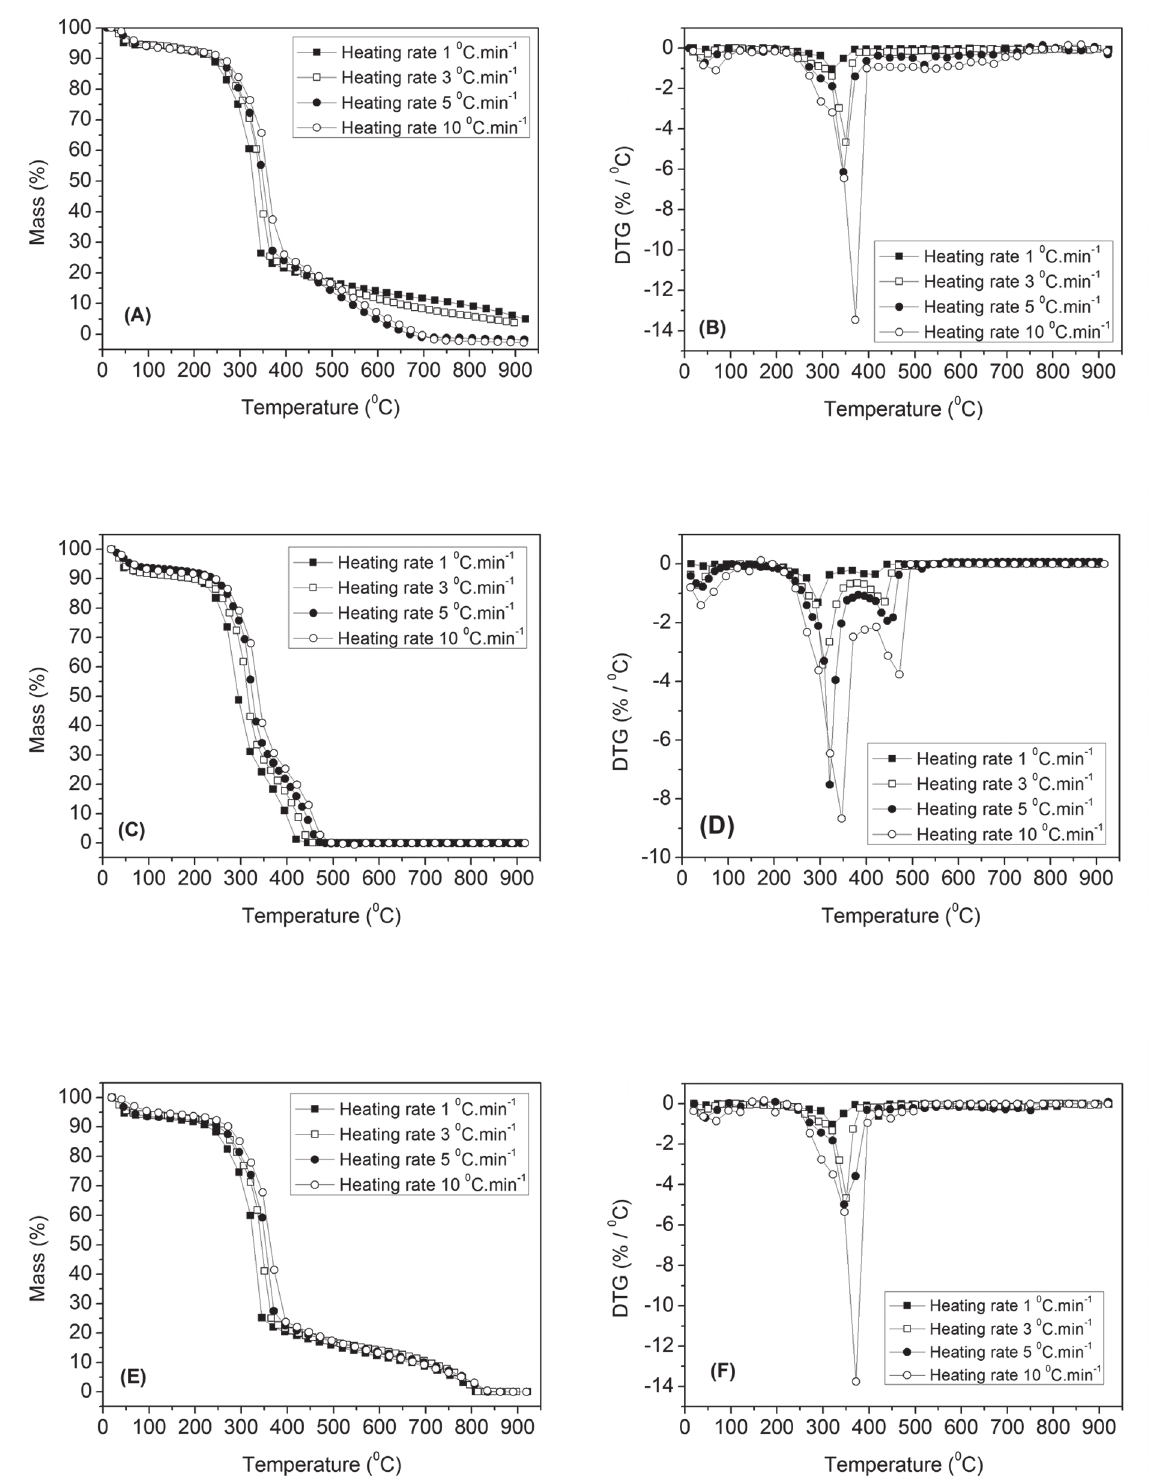
Fig. 3 - Jute fiber ( in natura ) thermogravimetry (TG) curves and derivate thermogravimetry (DTG) curves: (A) TG with inert gas; (B) DTG with inert gas; (C) TG with synthetic air; (D) DTG with synthetic air; (E) TG with CO